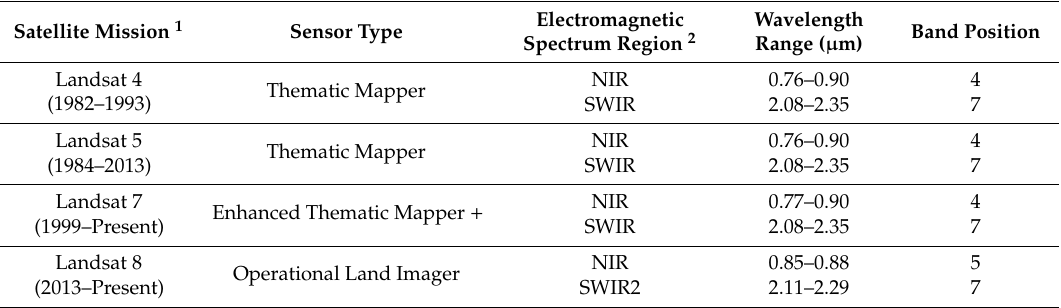
Table 1. Landsat missions incorporated for the development of the Monitoring Trends in Burn Severity (MTBS)